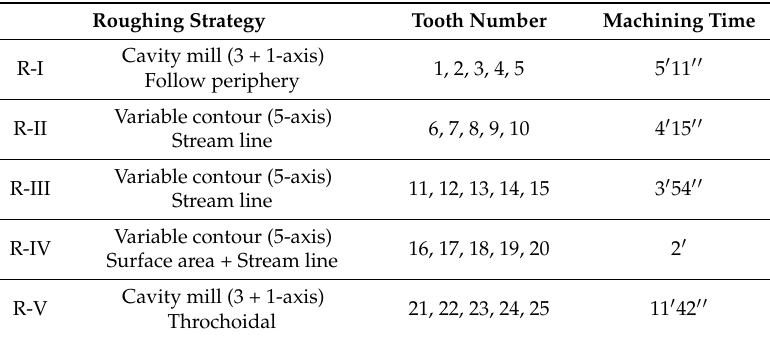
Table 4. Roughing strategies